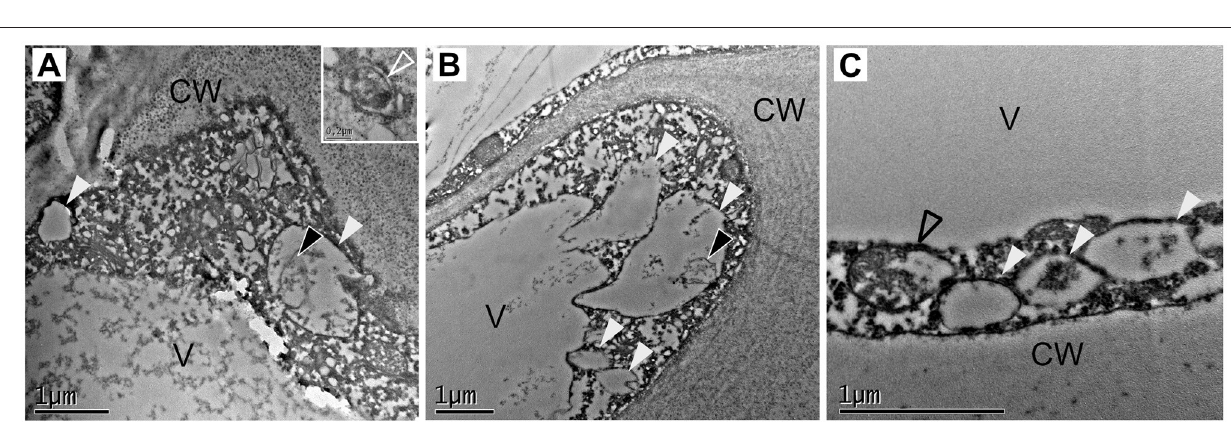
between lipidation levels of ATG8 at the white stage and depletion of NBR1 protein but not mRNA also in “Camarosa” ( Supplementary Figures 2B,C